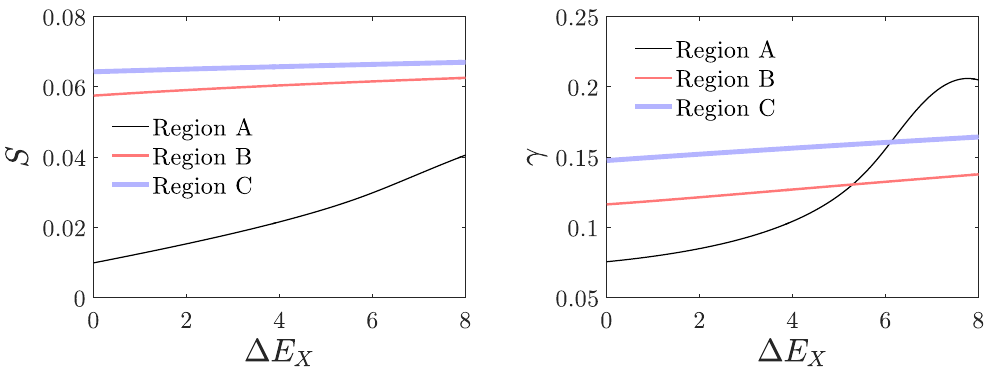
Figure 14. Influences of the driving voltage on mechanical sensitivity and nonlinearity; Region A: E X = ∆ E X + 4, E Y = 30, Region B: E X = ∆ E X + 20, E Y = 30, and Region C: E X = ∆ E X + 32, E Y =